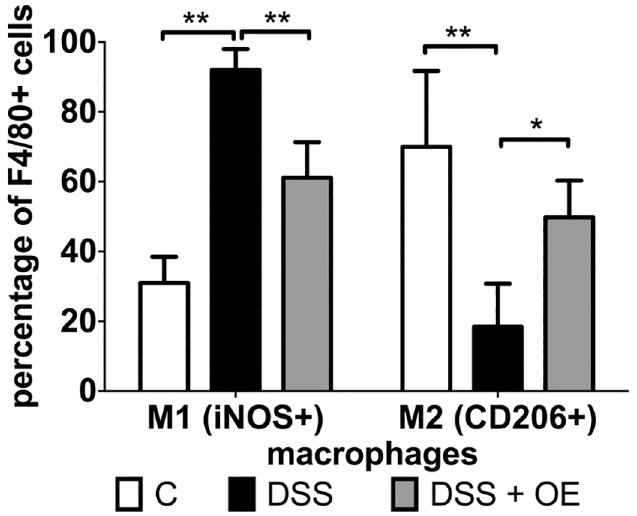
Fig 9. Effect of enoxaparin on macrophage phenotypes. Quantification of macrophages expressing M1 and M2 phenotype markers in the colon. Results are expressed as percentage of double-positive macrophages from total macrophages ± SD of five representative high-power fields per tissue section of n = 3 – 5 mice each. * p < 0.05 and ** p < 0.01.